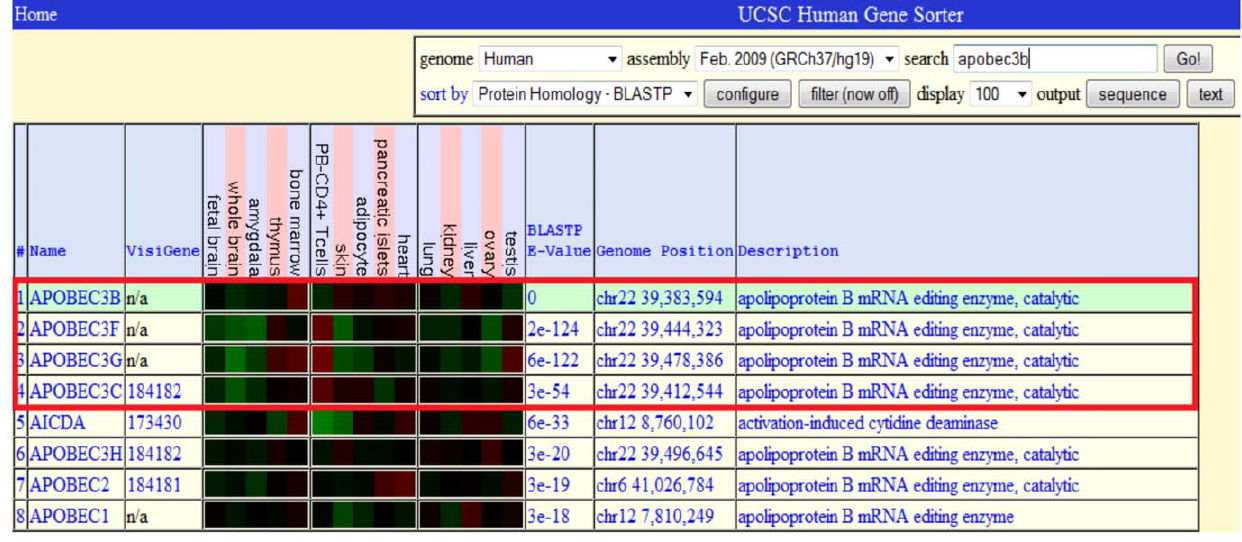
Figure 9. Comparison of protein homology between the APOBEC3B gene and the other genes.